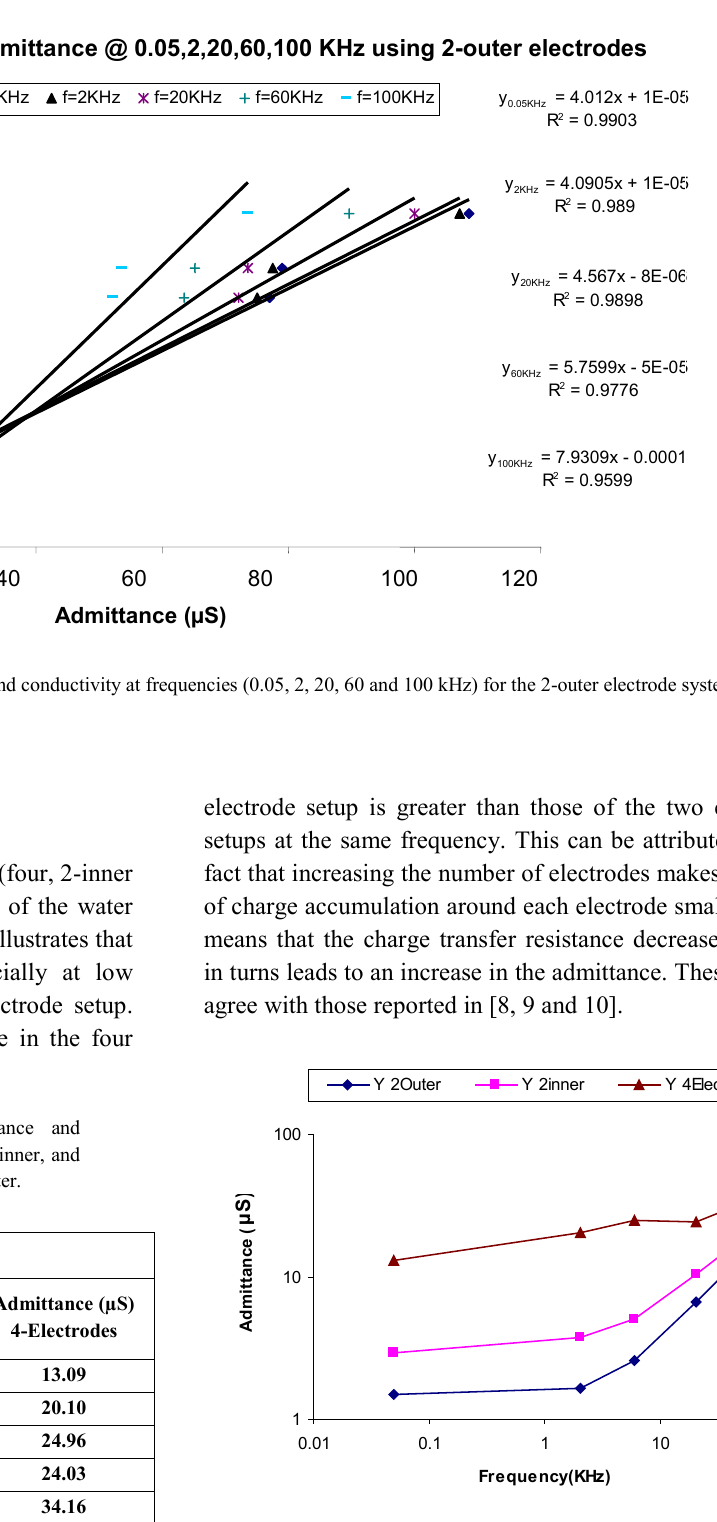
Figure (5): Admittance vs. frequency for the three experimental setups (4, 2-inner, and 2-outer electrodes) with the distilled water